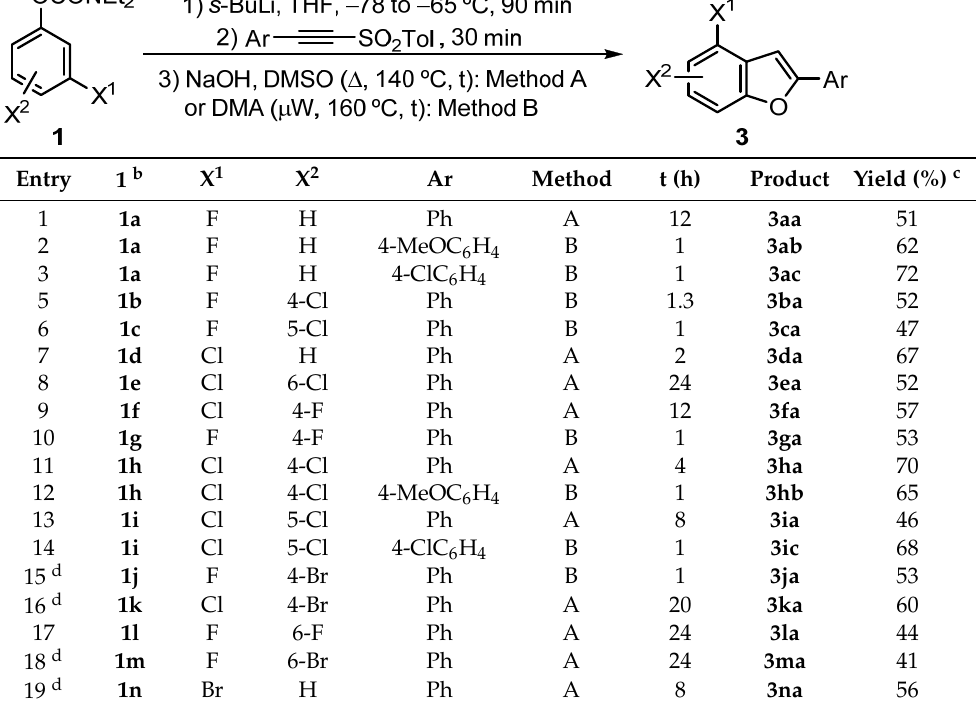
Molecules 2022 , 27 , x FOR PEER REVIEW 7 of 21